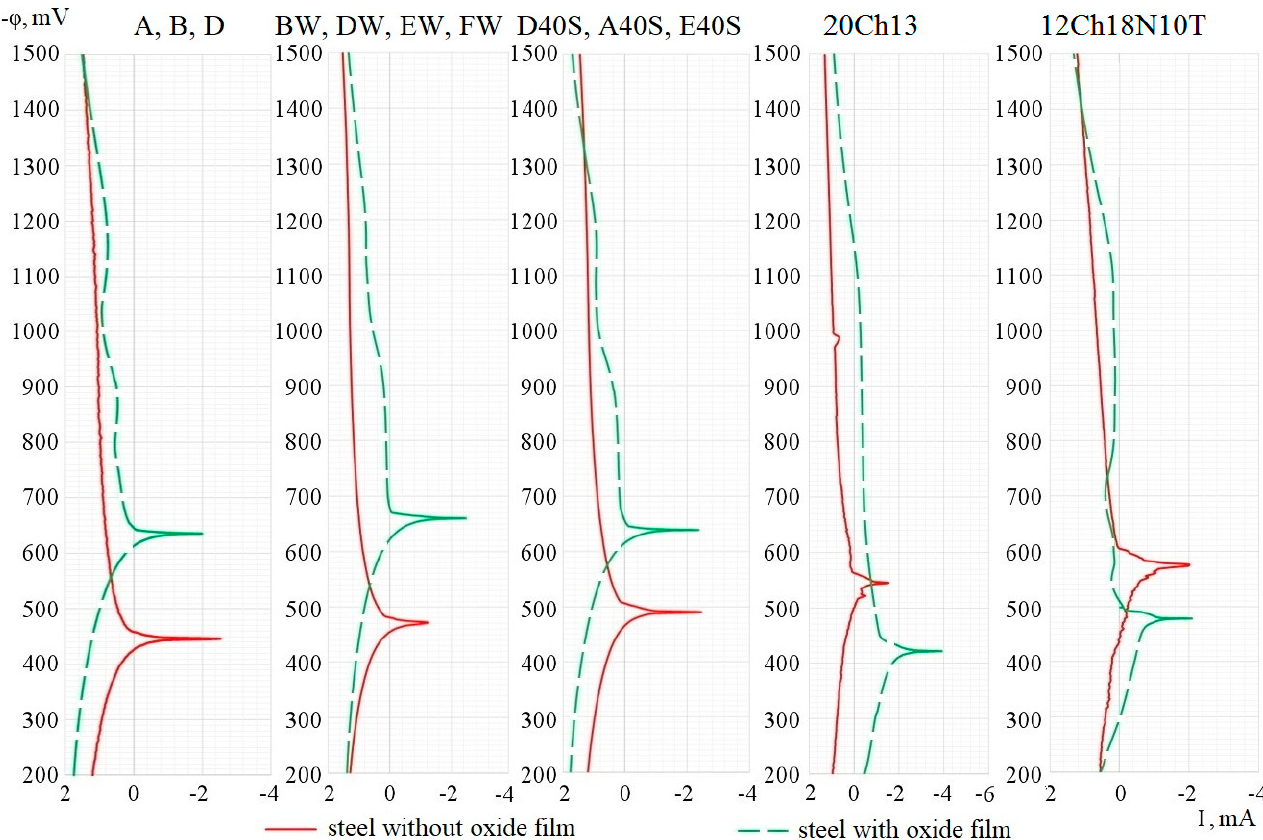
Figure 11. Potentiodynamic studies of steels in NaCl 1.8%.